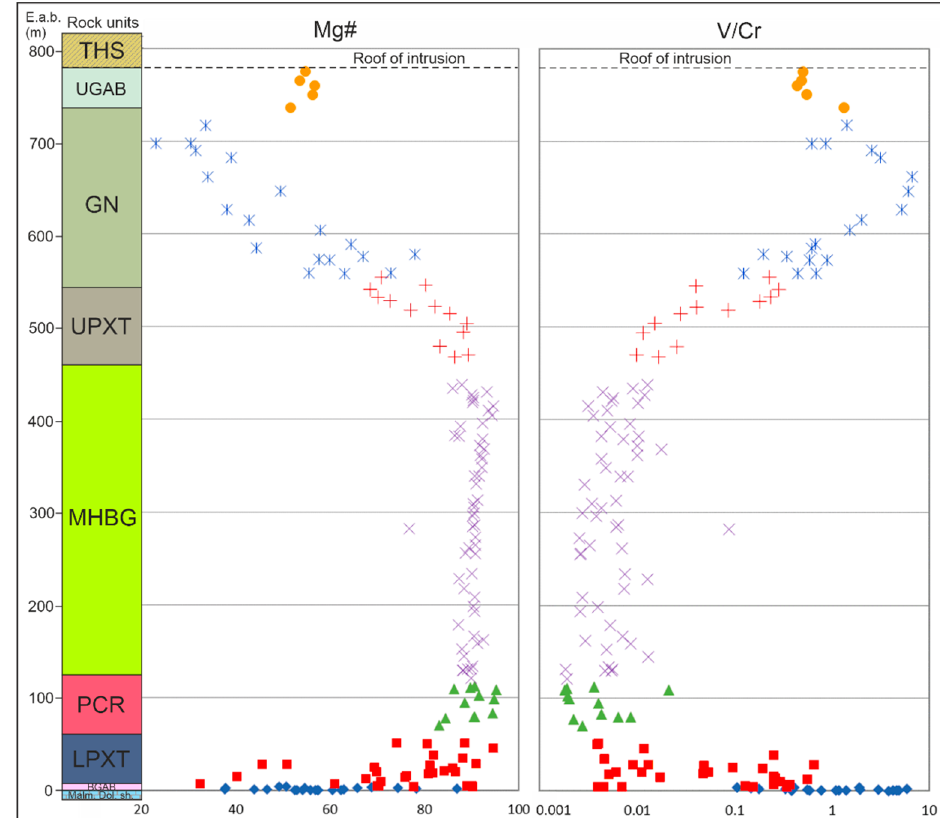
Figure 5. Geochemical and mineral chemistry composite profile of the Uitkomst Complex at LM (LM-1 and LM-4), SH and UK [3]. BGAB: Basal Gabbro, LPXT: Lower Pyroxenite, PCR: Chromitiferous Harzburgite, MHBG: Main Harzburgite, UPXT: Upper Pyroxenite, GN: Gabbronorite, UGAB: Upper Gabbro, Malm.Dol.sh.: sheared Malmani Dolomite, THS: Timeball Hill Shale, E.a.b.: Elevation above base, Mg#: Mg*100/(Mg + Fe 2+ ) in atomic proportions.